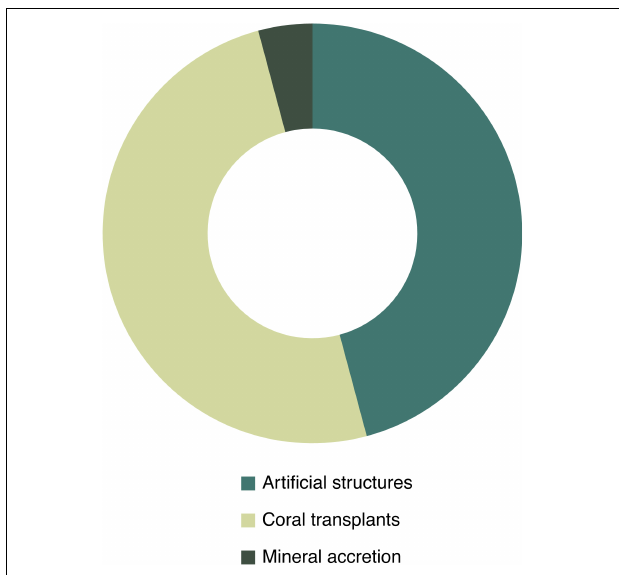
FIGURE 4 | Active restoration techniques studied in CWC restoration publications ( N =